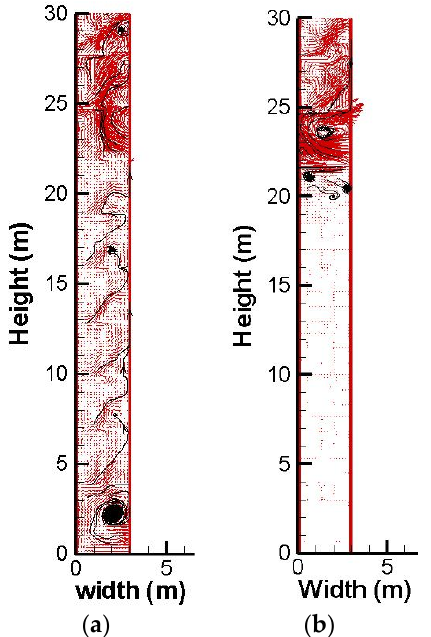
Figure 3. Temperature distributions in the staircase at 0 m/s. ( a ) Stair door opened on the first floor. ( b ) Stair doors closed.